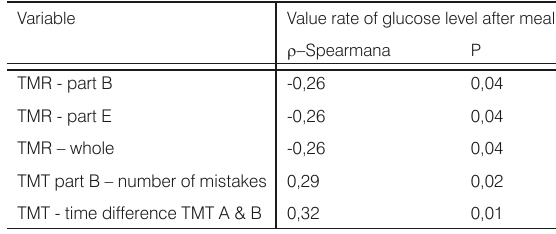
Table 2. The ρ -Spearman’s correlation coefficient for LDL cholesterol concentration in the blood and cognitive functions.